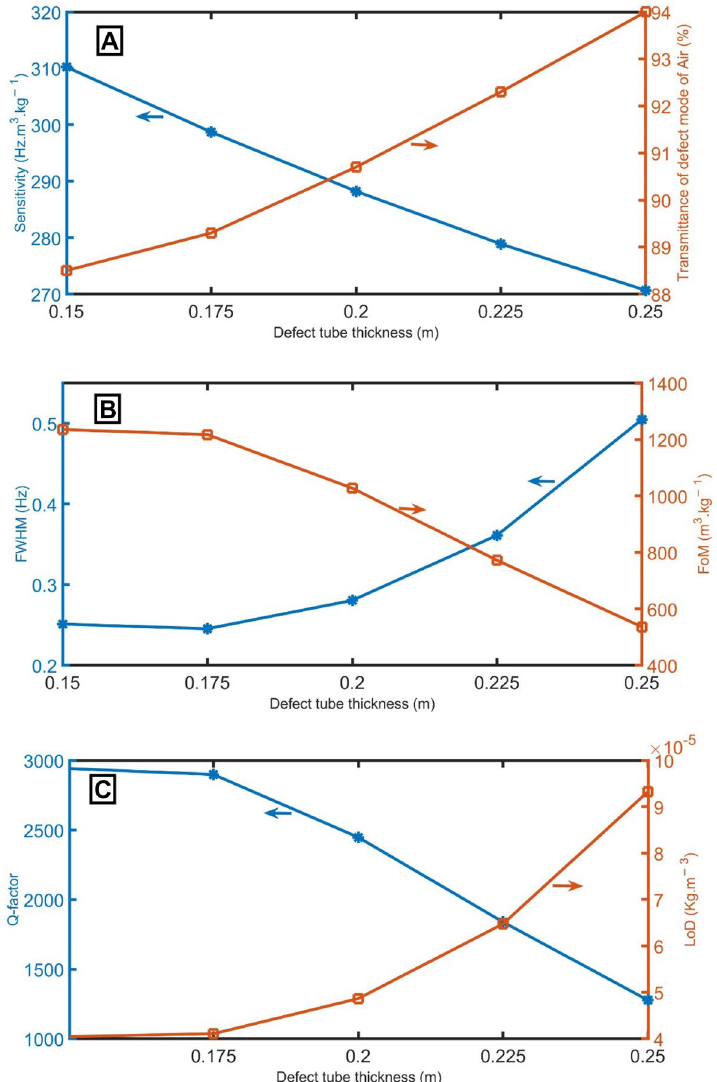
Figure 3. ( A ) sensitivity between air and pure CH 4 samples and transmittance of the resonant mode of air samples, ( B ) FWHM of the resonant mode of air samples and FoM , and ( C ) Q-factor and LoD of the proposed gas sensor at different values of defect tube